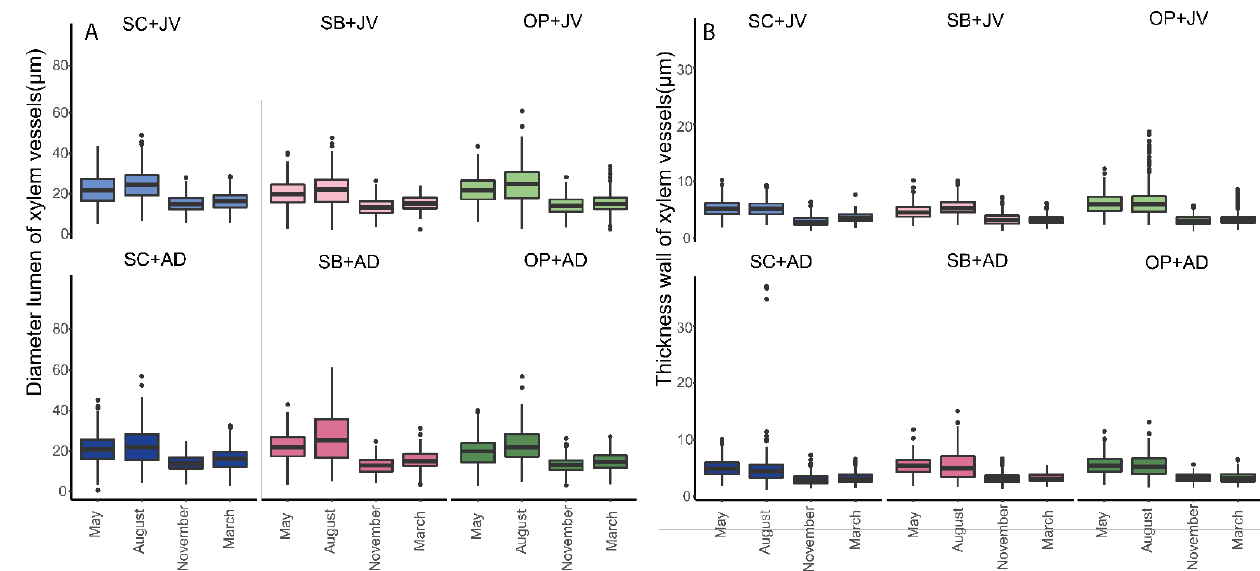
Figure 6. Morphoanatomical traits measured in juveniles and adults of R. mangle during four periods. ( A ) Diameter of the lumen of the xylem vessels. SC + JV: n = 1296, SB + JV: n = 1272, OP + JV: n = 1272, SC + AD: n = 1272, SB + AD: n = 1396, OP + AD: n = 1296. ( B ) Thickness of the wall of the xylem vessels. SC + JV: n = 1296, SB + JV: n = 1272, OP + JV: n = 1272, SC + AD: n = 1272, SB + AD: n = 1396, OP + AD: n = 1296.